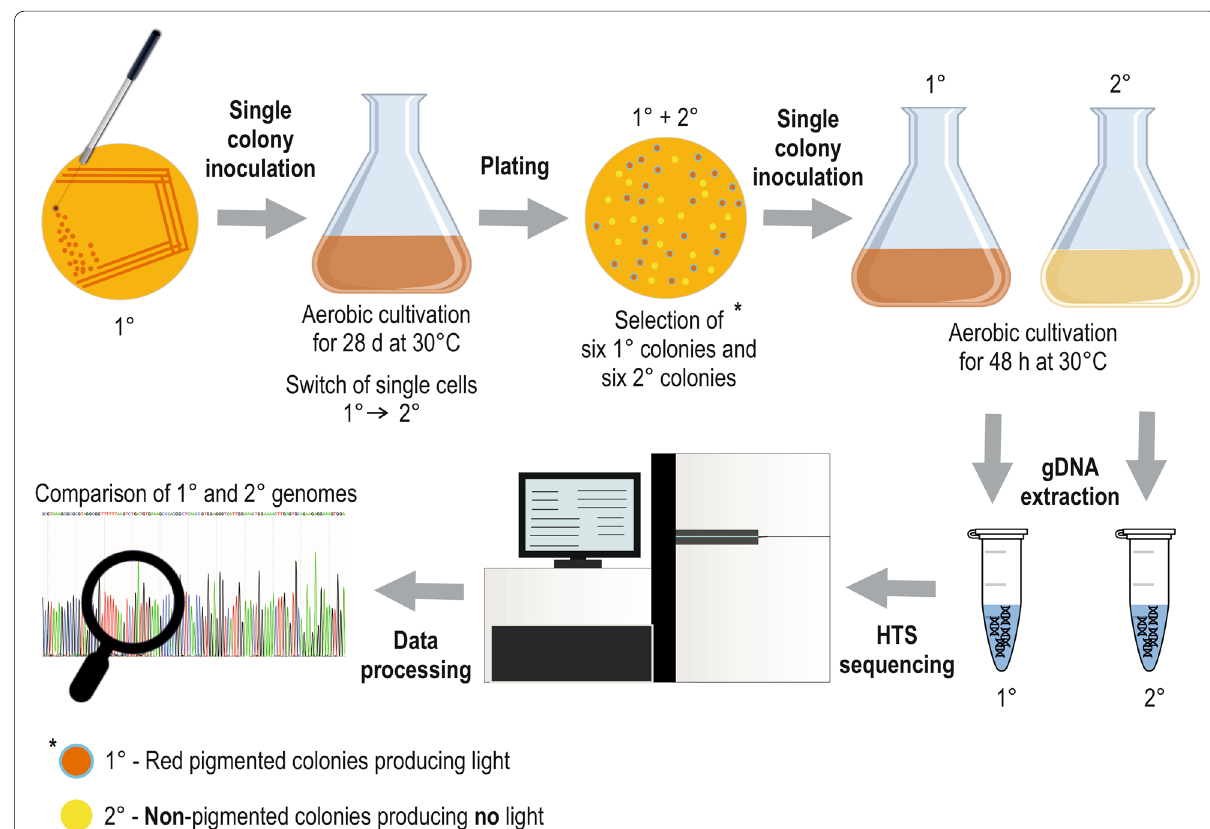
Fig. 1 Schematic presentation of the experimental workflow for genomic comparison between P. luminescens 1° and 2° variants. In brief, P. luminescens 1° cells were cultivated for 11 days so that a large proportion of single cells were switched to the 2° phenotype and then plated on LB agar. Then, six single colonies of each variant, 1° and 2°, were picked and cultivated; genomic DNA was isolated, analyzed by HTS, and resulting DNA sequence data was mapped against the P. luminescens ssp. laumondii DJC reference